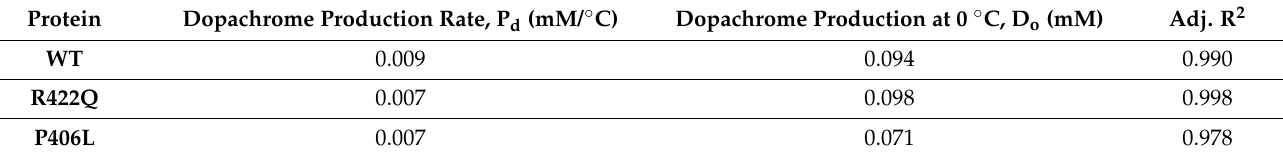
The parameters shown here are derived from the equation of the linear fit (D = P d × T − D o ) shown in Supplementary Materials Figure S2. Here D,